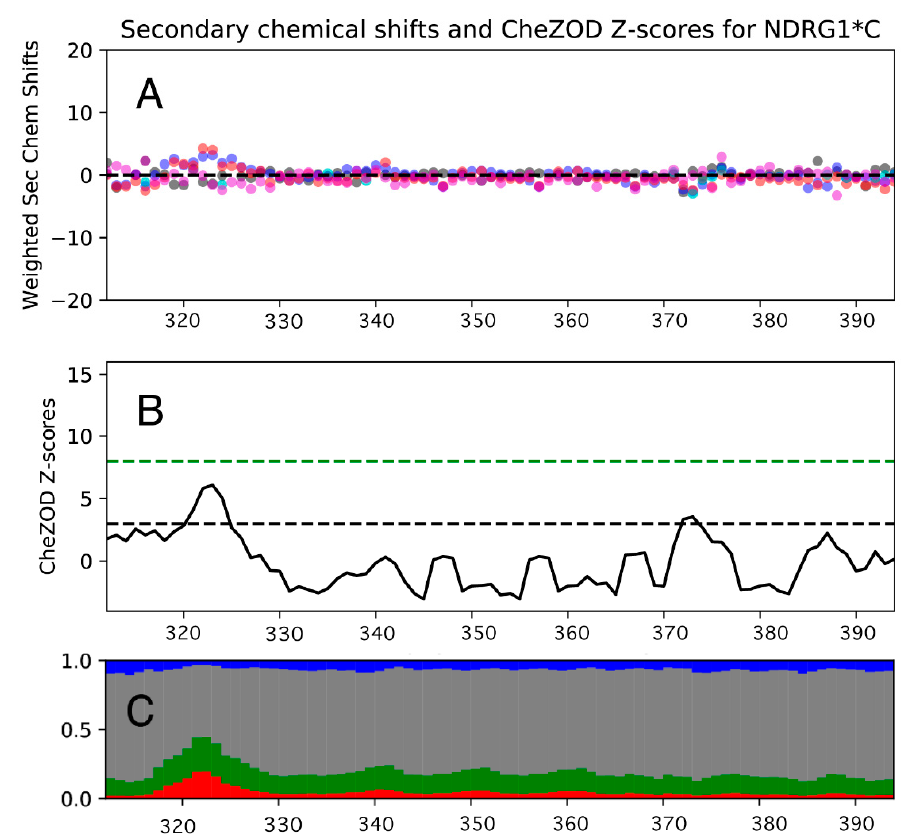
Figure 5. ( A ) Weighted secondary chemical shifts, ( B ) CheZOD Z-scores and ( C ) stacked bar plot of CheSPI populations of “extended” (blue), “helical” (red), “turn” (green) and “non-folded” (grey) local structures calculated for h NDRG1*C.